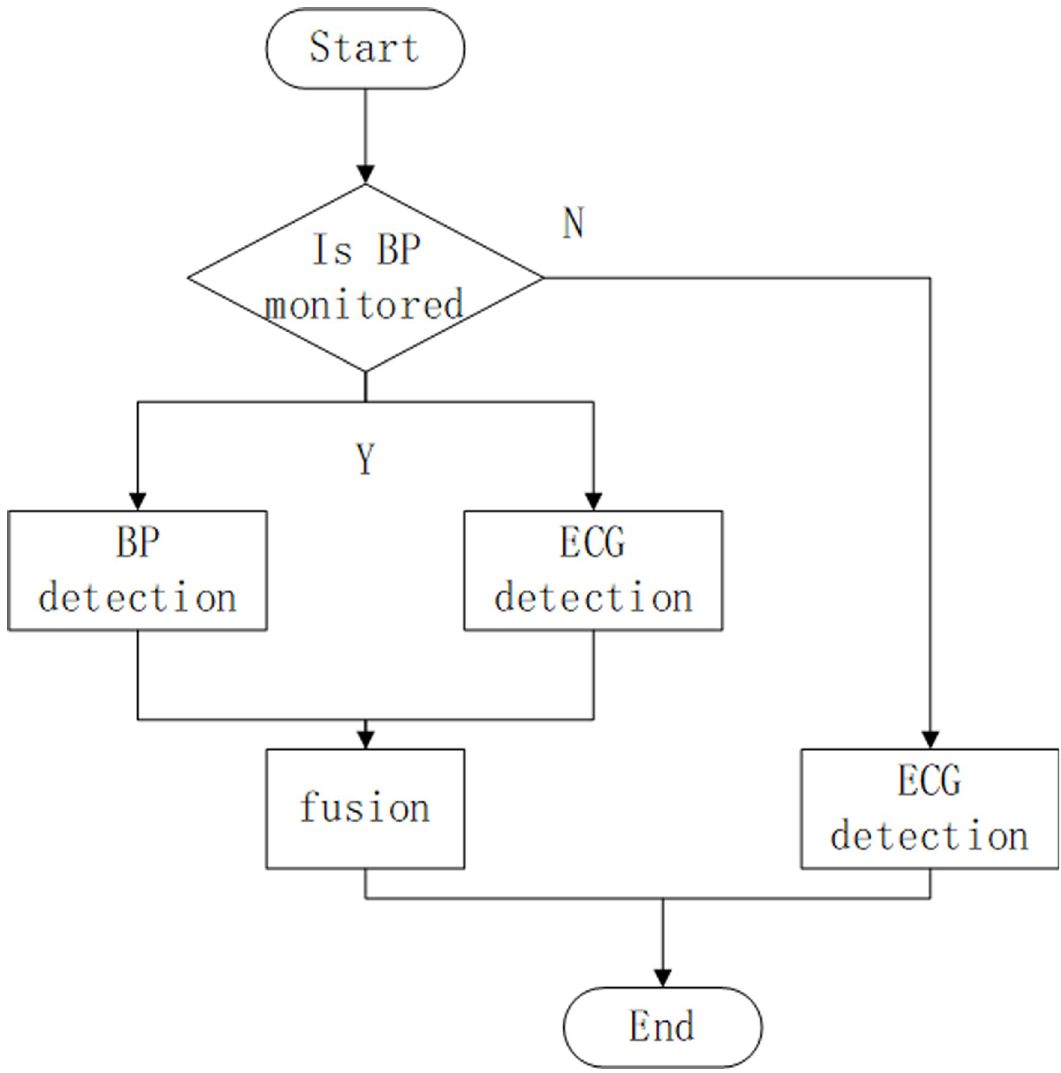
Fig 3. Overall block diagram for the proposed R-wave peak detection